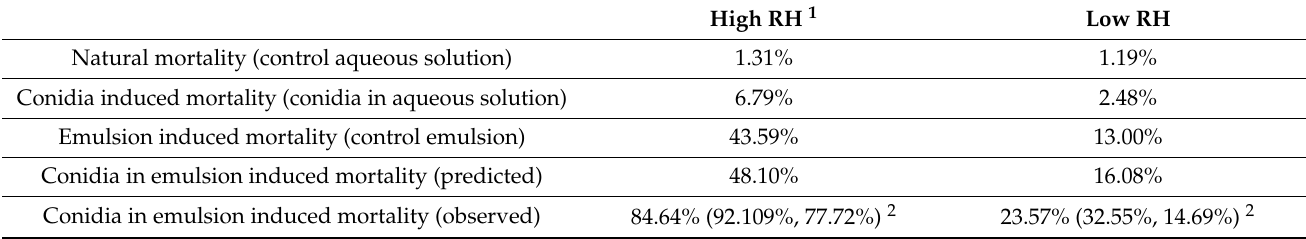
Table 2. Synergism assessment based on Bliss’s model for independent joint action of chemical pesticides.